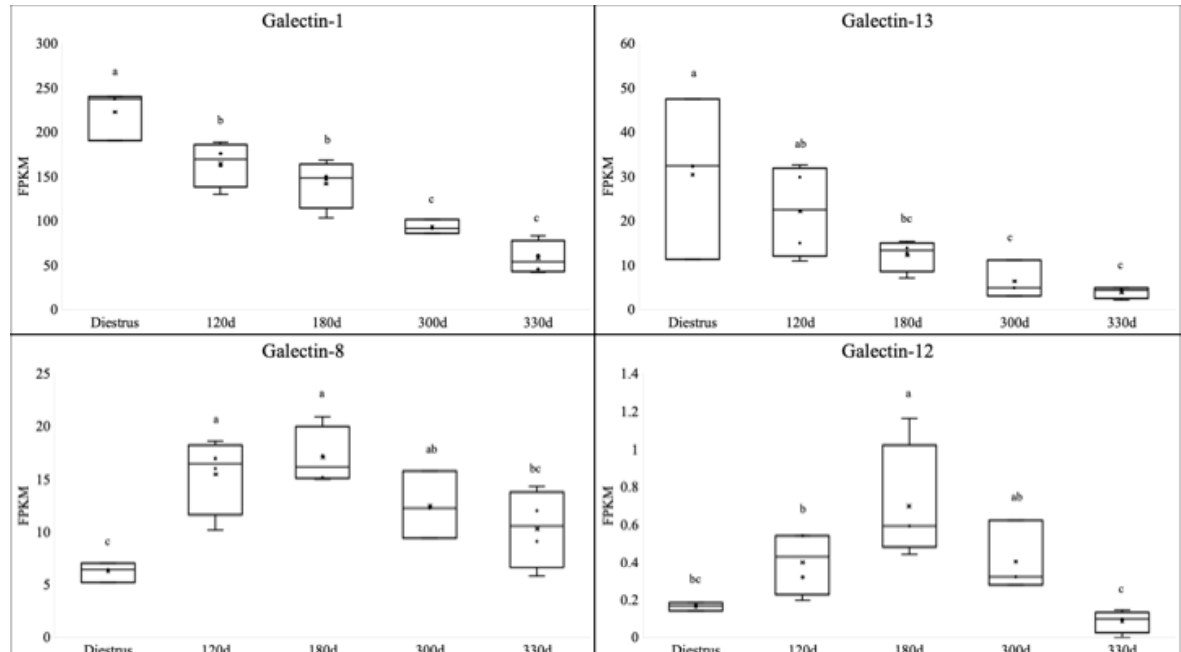
Figure 1. Expression of galectins in the endometrium during equine gestation. The expression of galectin-1 and galectin-13 followed a similar profile and were highest in the nonpregnant mare. This expression then decreased throughout gestation and was lowest in the 330 d gestation samples. A similar profile was noted for the expression of galectin-8 and galectin-12, where expression was low in the nonpregnant endometrium, increased in the pregnant endometrium, and reached the highest expression levels in mid-gestation at 180 d of gestation. The expression of galectin-8 and galectin-12 then decreased as parturition neared, and they were at nonpregnant levels by 330 d of gestation. All gene expression data are displayed as the fragments per kilobase of exon per million mapped (FPKM) ± SEM. a,b,c,d values with different superscripts differ; p < 0.05.